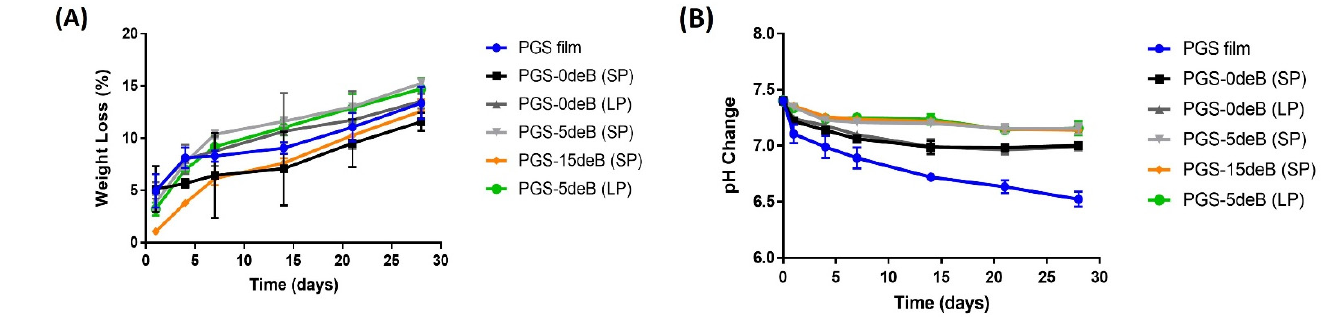
Figure 5. The degradation ( A ) and pH change ( B ) of physiological Tris–HCl buffer regarding the PGS-deB blend scaffolds and PGS film.